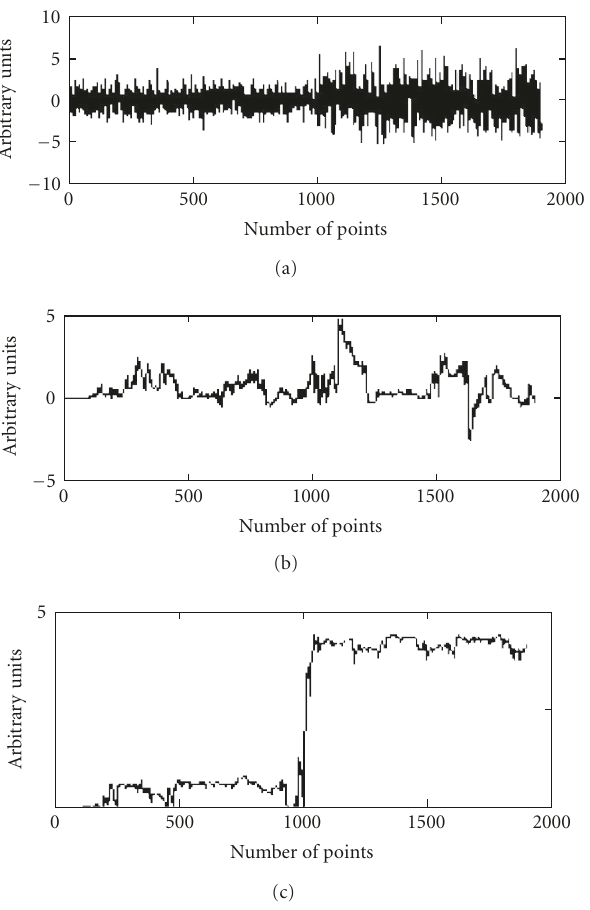
Figure 3: An illustration of a change that was not detected by the DCS algorithm. Upper tracing: signal segment. Middle tracing: DCS evolution. Lower tracing: detection function evolution. For all tracings, x -axis: number of points, y -axis: arbitrary units.